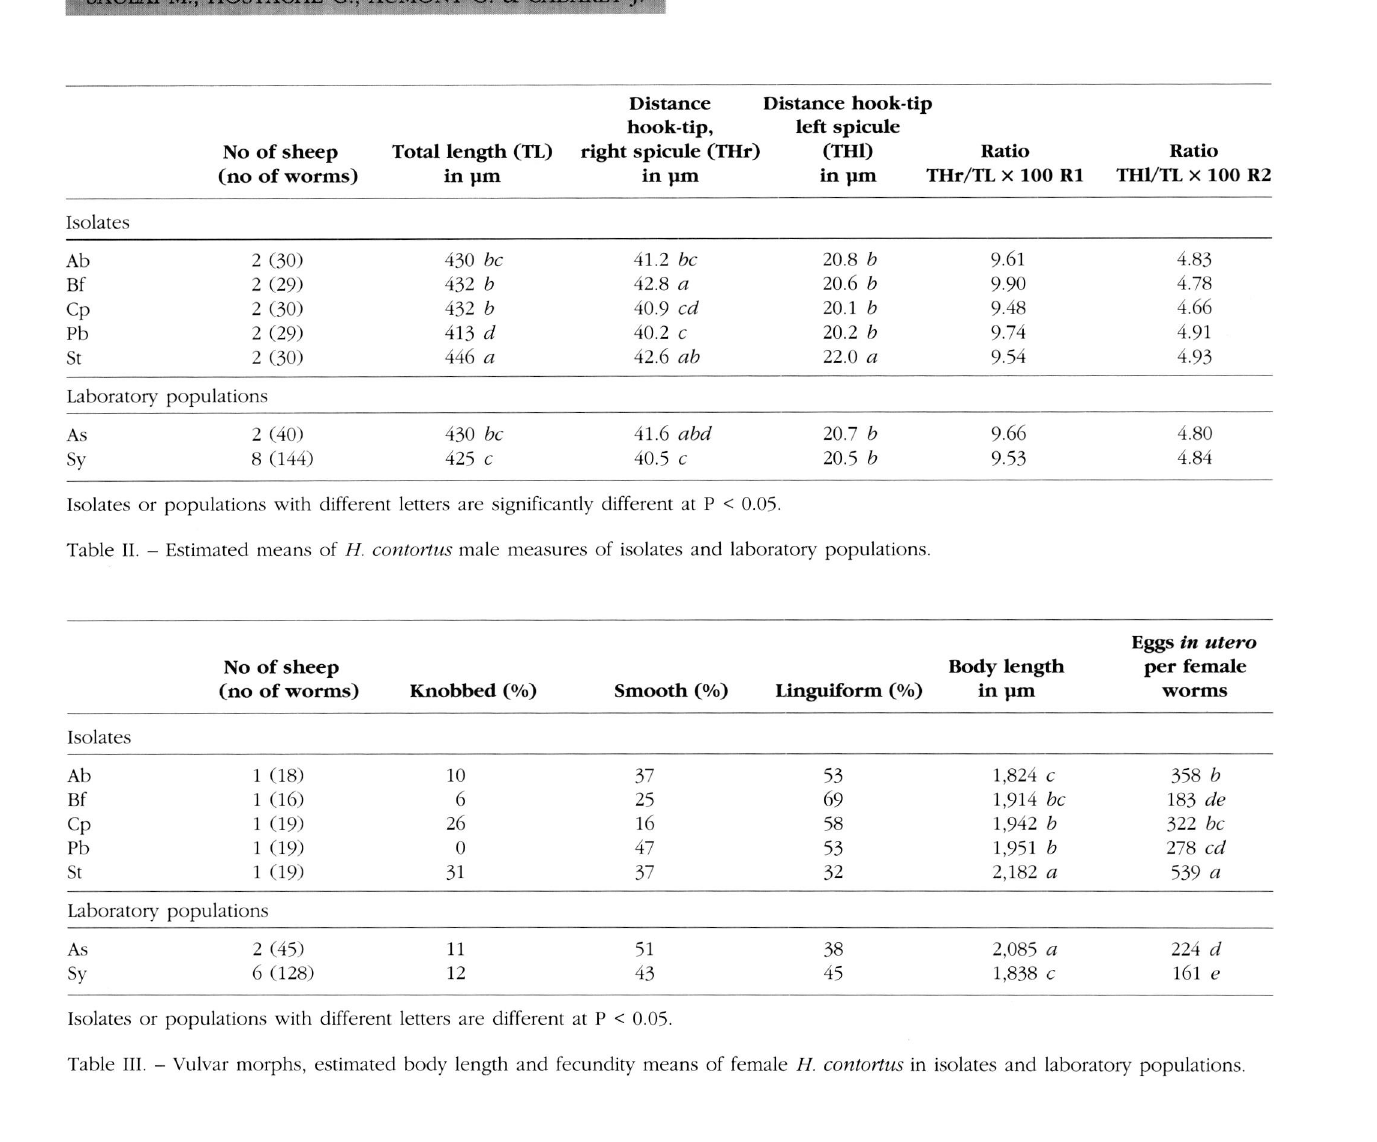
Table III. - Vulvar morphs, estimated body length and fecundity means of female H. contortus in isolates and laboratory populations.